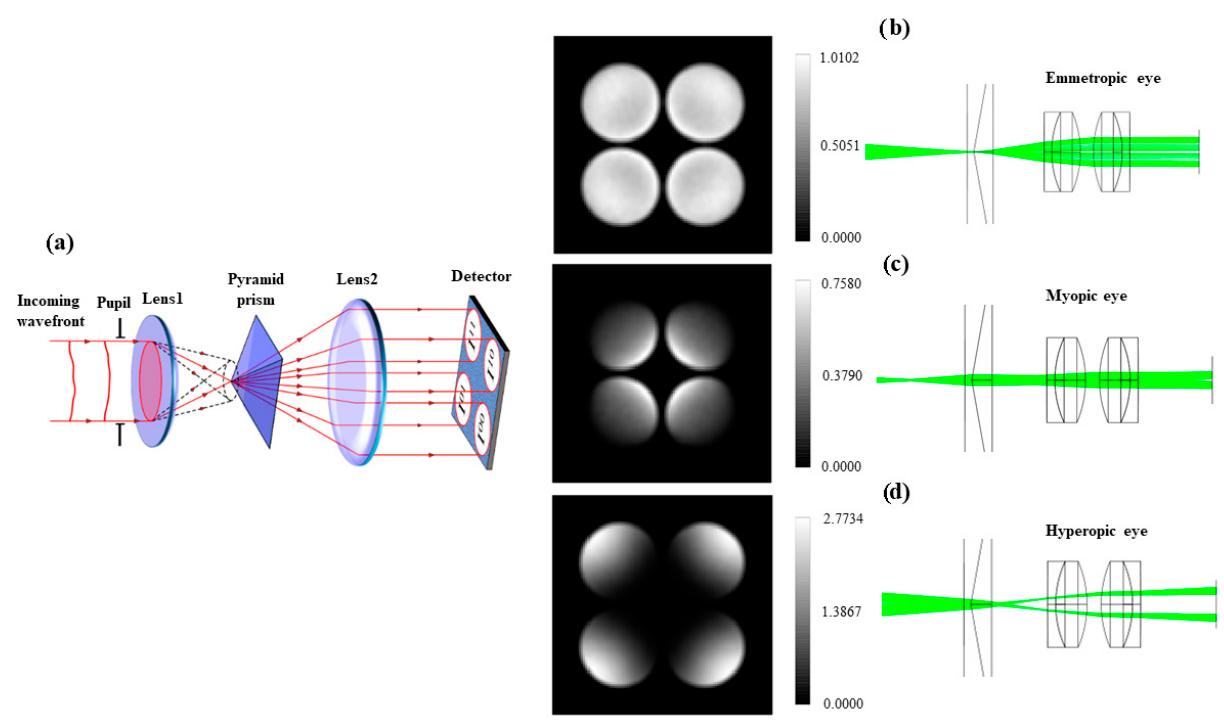
Figure 5. ( a ) Pyramid sensor (adapted with permission from Ref. [58] I. Shatokhina, V. Hutterer, R. Ramlau, Review on methods for wavefront reconstruction from pyramid wavefront sensor data, Journal of Astronomical Telescopes, Instruments, and Systems , 6 (1), 010901 (2020). © 2020 Society of Photo-Optical Instrumentation Engineers (SPIE). ( b – d ) Simulated CCD images of the source at different pyramid positions and Zemax images showing the ray behavior close to the PS for different aberrations. See main text for details.